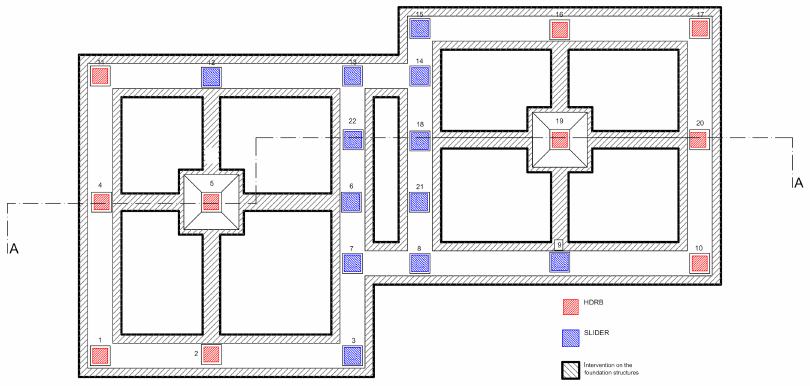
Figure 2. Plan view of the isolation system’s